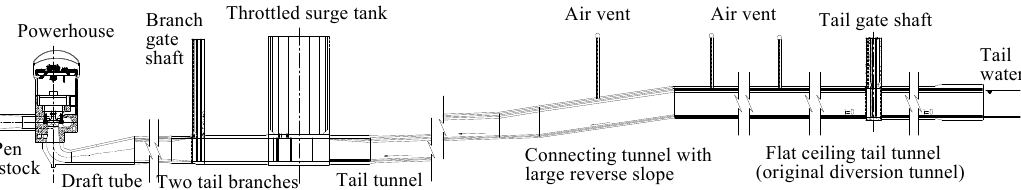
Figure 1. Hydropower system with a flat ceiling tail tunnel.